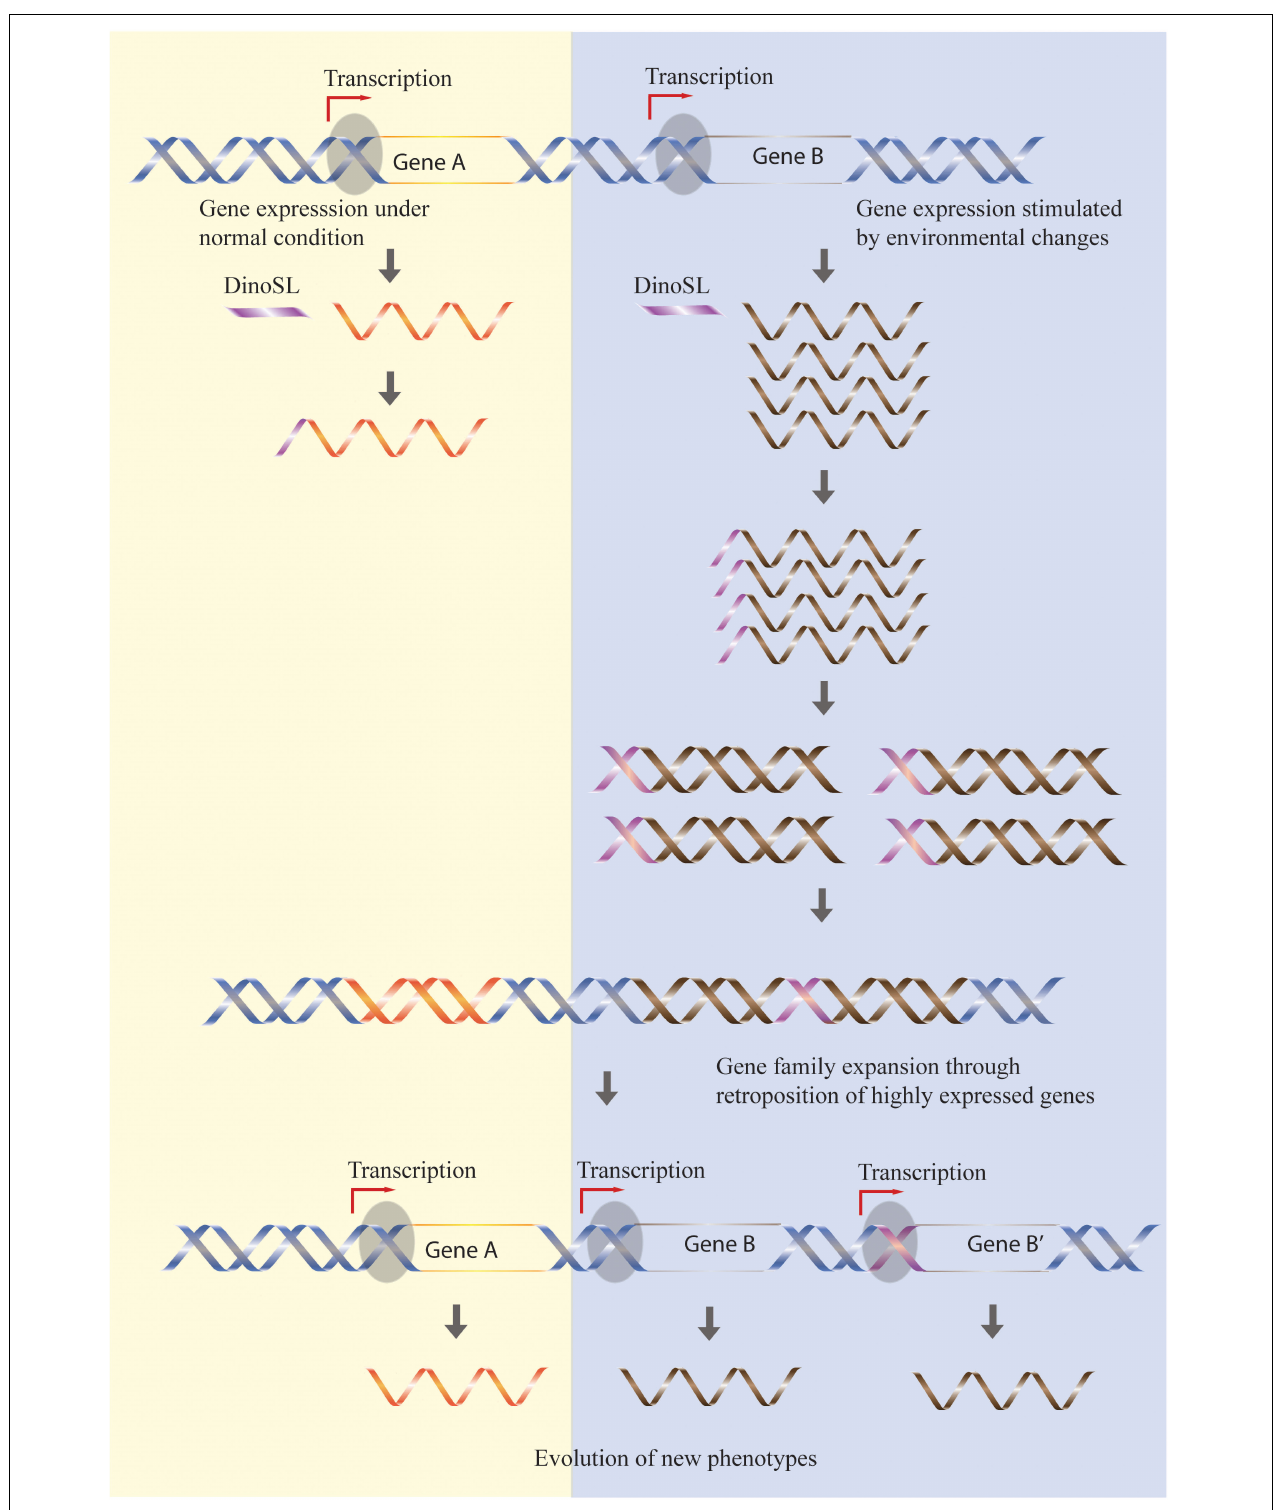
FIGURE 1 | Retroposition mediates the expansion of gene families responsive to stress. Genes highly expressed by certain environmental conditions (gene B) have higher chances to be retroposed, so the increased expression level is fixed in the genome through an increased retrogene copy number. In contrast, gene families not stimulated by environmental stress (gene A) remain constant during evolution. The different rate of retroposition of these two classes of genes will thus allow accumulation of genes responsive to environmental changes.